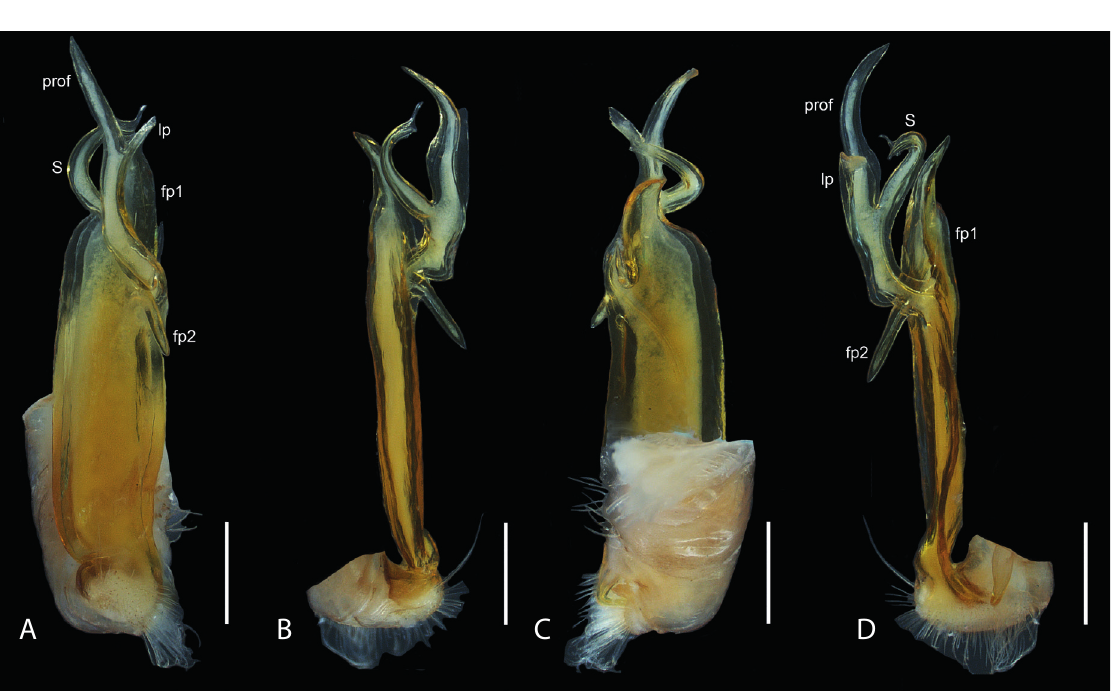
Fig. 23. Pogonosternum montanum Decker, sp. nov., ♂, paratype from Mt Beauty, right gonopod (AMS KS106738). A . Posterior view. B . Lateral view. C . Anterior view. D . Mesal view. Abbreviations: see Material and methods. Scale bars: 0.5